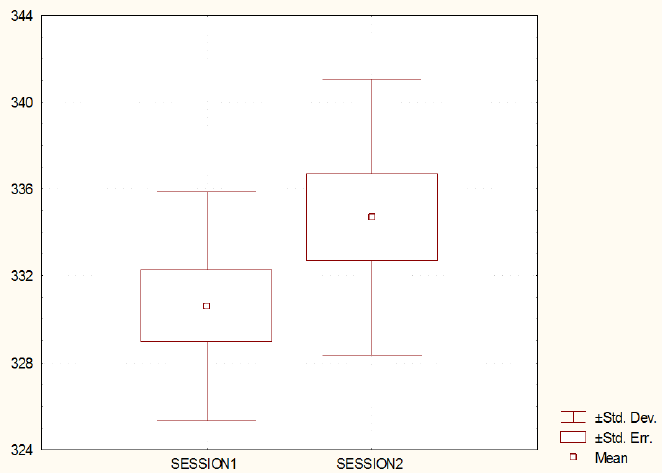
Figure 1 . Box and whisker plots for data collected during sessions one and two are shown. The means, standard error on the means and the standard deviation from the means are